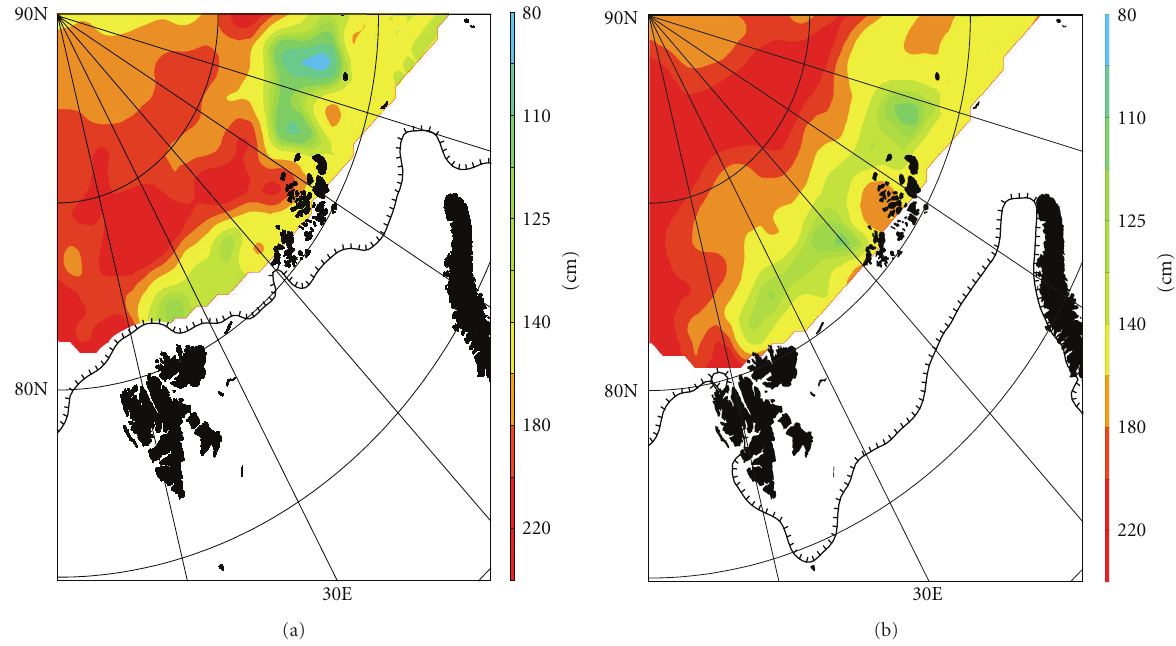
Figure 6: October-November, 2007 ice thickness (a); February-March, 2008 ice thickness (b). Black solid lines show the location of the ice edge, defined by 15% ice